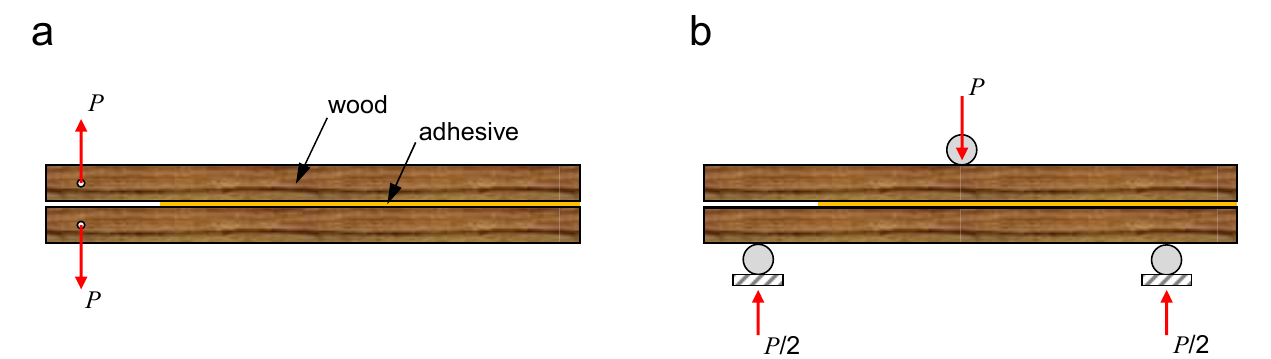
Figure 8. Simplified schemes of the ( a ) DCB and ( b ) ENF test configurations for studying the fracture behaviour of wood adhesive joints.